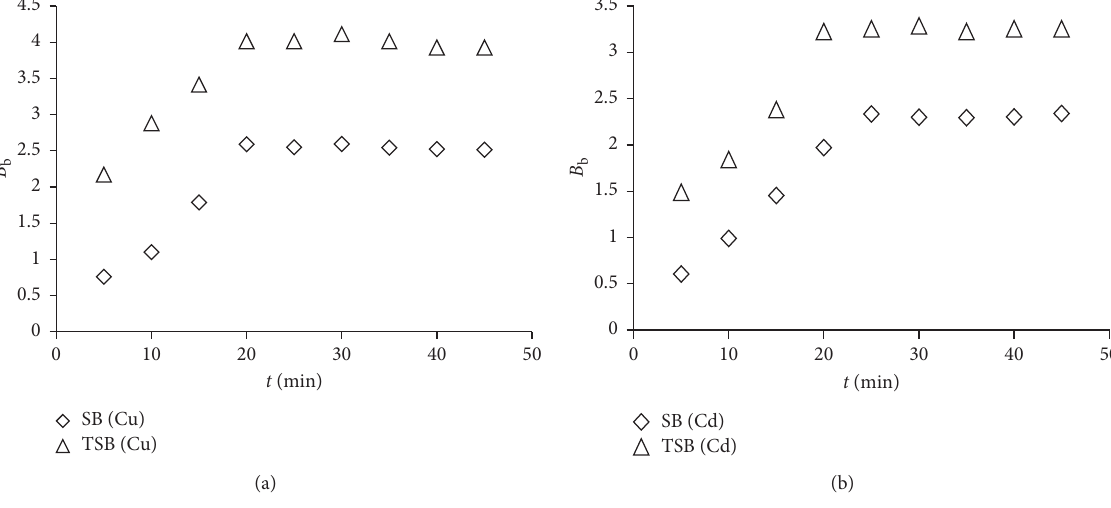
Figure 7: Boyd plots for the biosorption of (a) Cu(II) and (b)